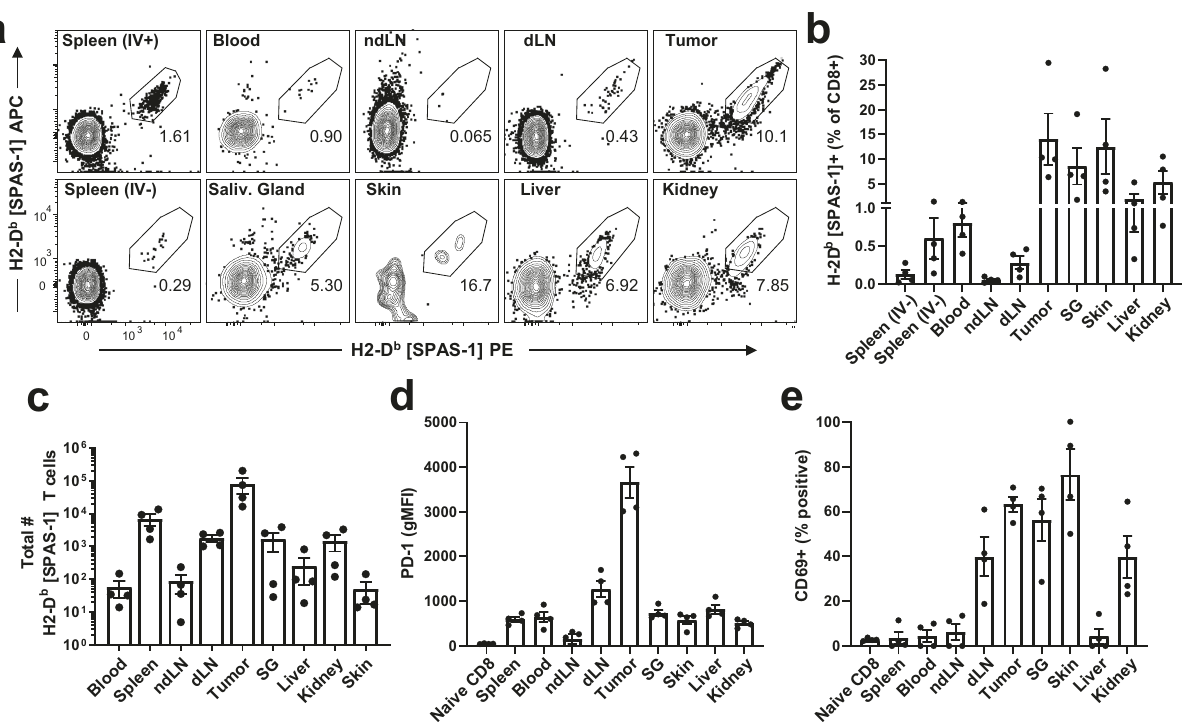
Fig. 2 SPAS-1 + T cells are broadly distributed in lymphoid and non-lymphoid tissues following TRAMP-C2 tumor challenge. Mice were challenged s.c. with TRAMP-C2 in the fl ank and necropsies were performed 28 days later. Mice were injected i.v. with 3 µ g of FITC-labeled anti-CD8 α antibody 3 min prior to harvest, to identify CD8 + T cells in the circulation. Single-cell suspensions from the indicated organs were prepared (see Methods) and stained for fl ow cytometry. a Representative FACS plots showing dual fl uorescent staining for SPAS-1 tetramer within the CD8 + IV- gate (see Supplementary Fig. 1a, b). b , c Quanti fi cation of replicate mice showing the frequency and total number of SPAS-1 + T cells. d – e Expression of PD-1 and CD69, respectively, on gated IV- SPAS-1 + T cells. See also Supplementary Fig. 1c. Results in ( b – e ) represent four biologically independent replicates from three independent experiments assessing SPAS-1 + CD8 + T cells in these tissues. Bars represent mean ± S.E.M. IV intravascular ( − or + ), SG salivary gland, dLN tumor- draining lymph node, ndLN non-draining LN. Source data are provided as a Source Data (Fig. 2a – c). In contrast to the spleen, blood, and non-draining lymph nodes, SPAS-1 T cells in the tumor expressed high levels of PD-1 (Fig. 2d, left, and Supplementary Fig. 1c). We also detected SPAS-1 speci fi c T cells in several NLTs including liver, lung, kidney, salivary gland, and skin (Fig. 2a – c, Supplementary Fig. 1b). Speci- fi